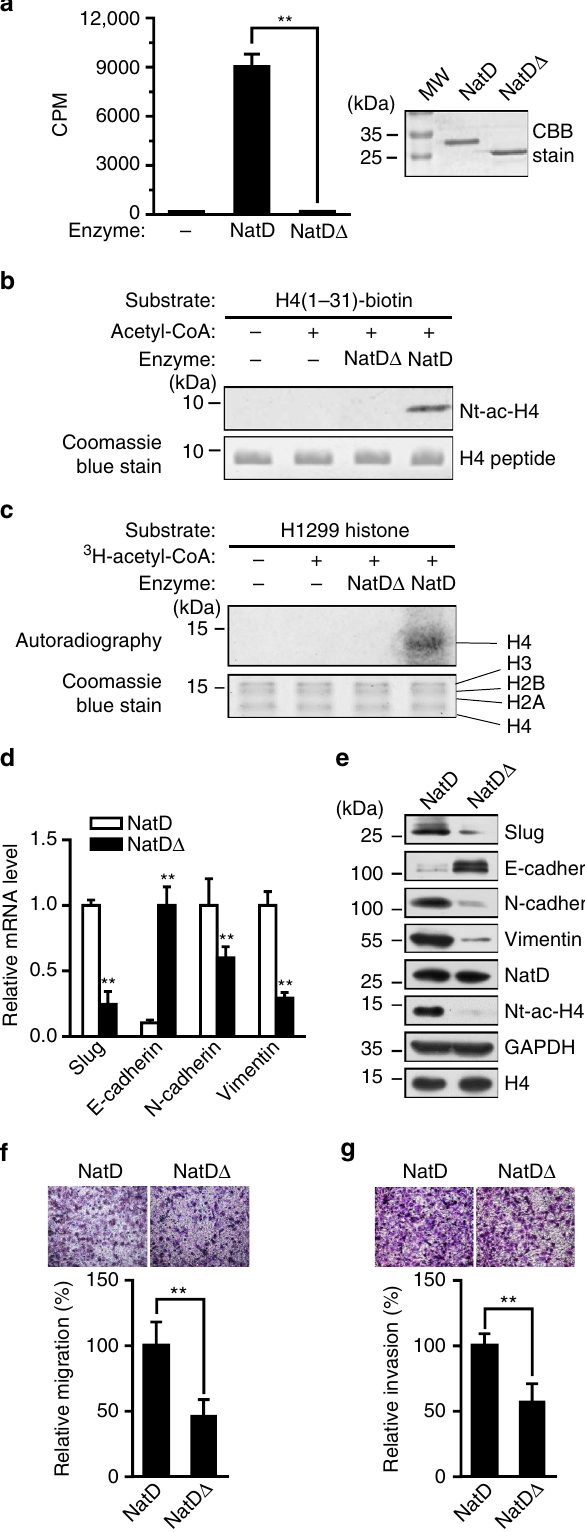
( left ) In vitro acetylation assay showing the catalytic activity of NatD Δ and wild-type NatD (CPM, counts per minute). Data are mean ± s.d. of three independent experiments; Student ’ s t -test, ** P < 0.01 compared with wild- type NatD. ( right ) SDS-PAGE analysis of puri fi ed recombinant NatD Δ and wild-type NatD proteins from E. coli stained by Coomassie brilliant blue (CBB). MW, protein molecular weight markers. b ( top ) Western blot analysis of an H4 (1 – 31) peptide from in vitro acetylation assay in the presence of NatD Δ or wild-type NatD. ( bottom ) H4 (1 – 31) peptide shown by Coomassie blue staining. Blots are representative of three independent experiments. c ( top ) Autoradiographic image showing products from in vitro acetylation assay using histones as substrates extracted from H1299 cells. Results are representative of three independent experiments. ( bottom ) Histones shown by Coomassie blue staining. d Quantitative real- time PCR analysis of mRNA levels of Slug , E-cadherin , N-cadherin , and Vimentin normalized to GAPDH in H1299 cells overexpressing NatD Δ or wild-type NatD. Data are mean ± s.d. of three independent experiments; Student ’ s t -test, ** P < 0.01 compared with the wild-type NatD. e Western blot analysis of indicated proteins from H1299 cells overexpressing NatD Δ or wild-type NatD. GAPDH and histone H4 served as loading controls. Data are representative of three independent experiments. f , g Representative images of the migration ( e ) and invasion ( f ) of H1299 cells overexpressing NatD Δ or wild-type NatD with transwell assay from three independent experiments ( top panel ). Cell counts for the corresponding assays of at least four random microscope fi elds (×100 magni fi cation). Cell migration and invasion are expressed as a percentage of control ( bottom panel ). Results are shown as mean ± s.d. from three independent experiments. Two-tailed Student ’ s t -test was used. ** P < 0.01 compared with the indicated control